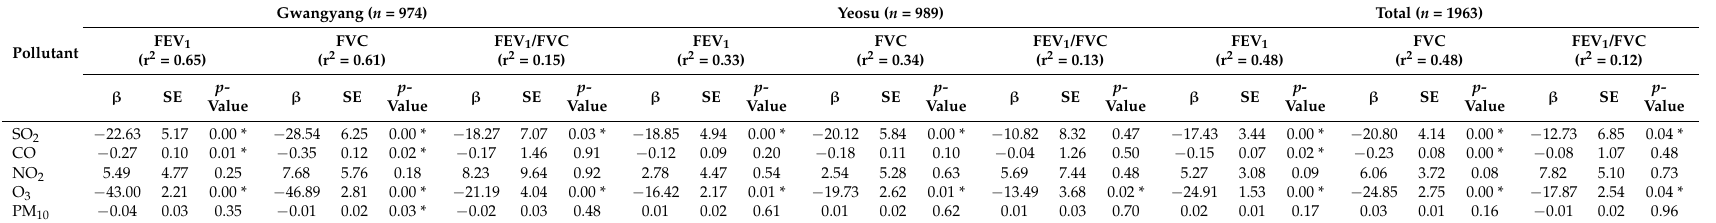
Table 6. Multiple linear regression analysis for pulmonary function levels by air pollutant in each area.